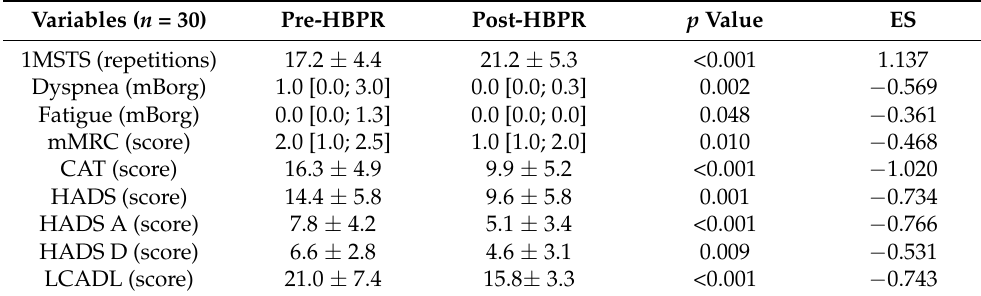
Table 2. Outcome values before and after home-based pulmonary rehabilitation.